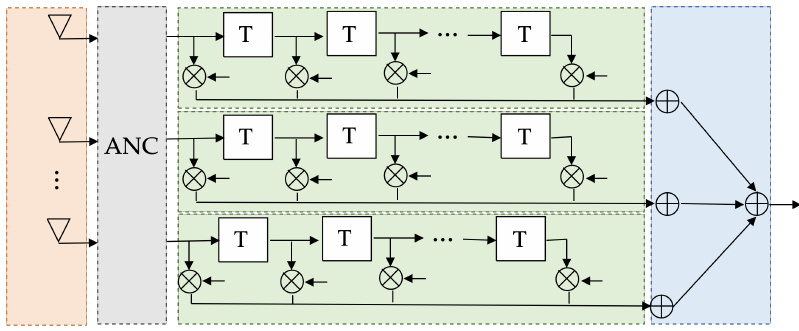
Figure 1. A typical STD structure using ANC processing.